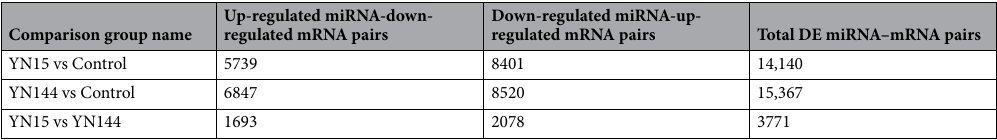
Table 2. Number of inversely DE miRNA–mRNA pairs. Table displaying the numbers of DE miRNA–mRNA pairs between the three comparison